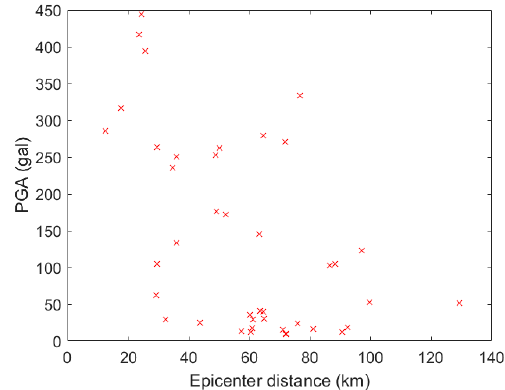
Figure 6. The distribution of the PGA and epicenter distance of the strong motions in the second dataset (Meinong earthquake).